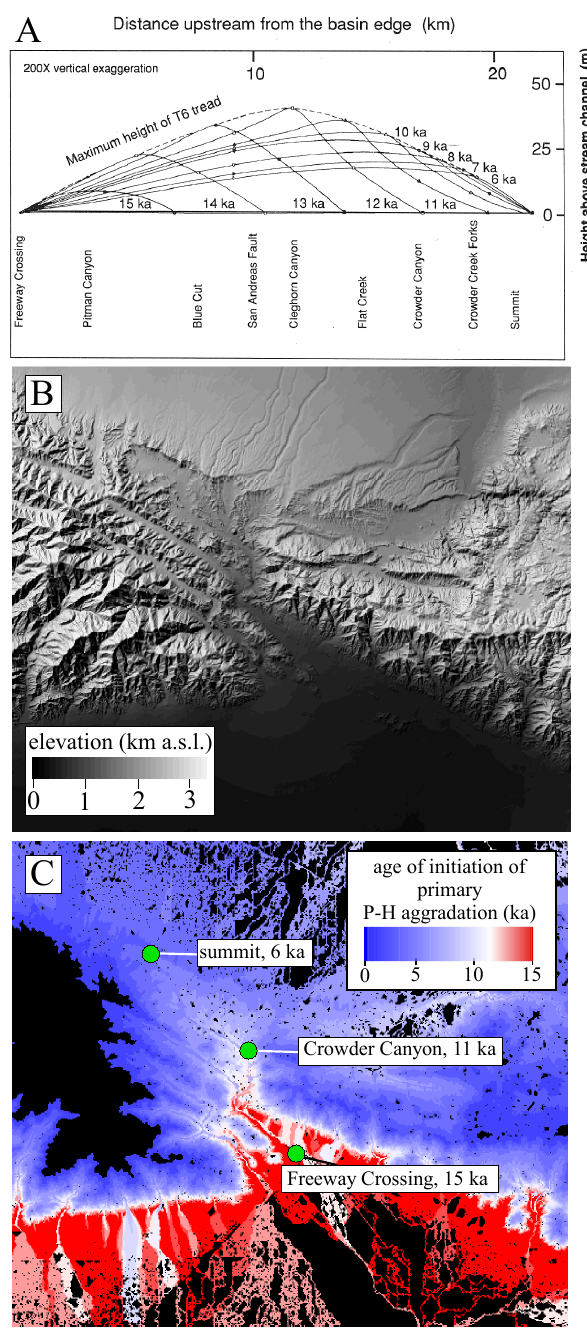
Figure 10. Comparison of (a) measured (from Bull, 1991 after Wel- don, 1986) and (c) predicted age of initiation of primary aggradation in Cajon Pass, California, according to the PVCH. Location of (c) shown in Fig. 4. Shaded-relief map of the area shown in (b)